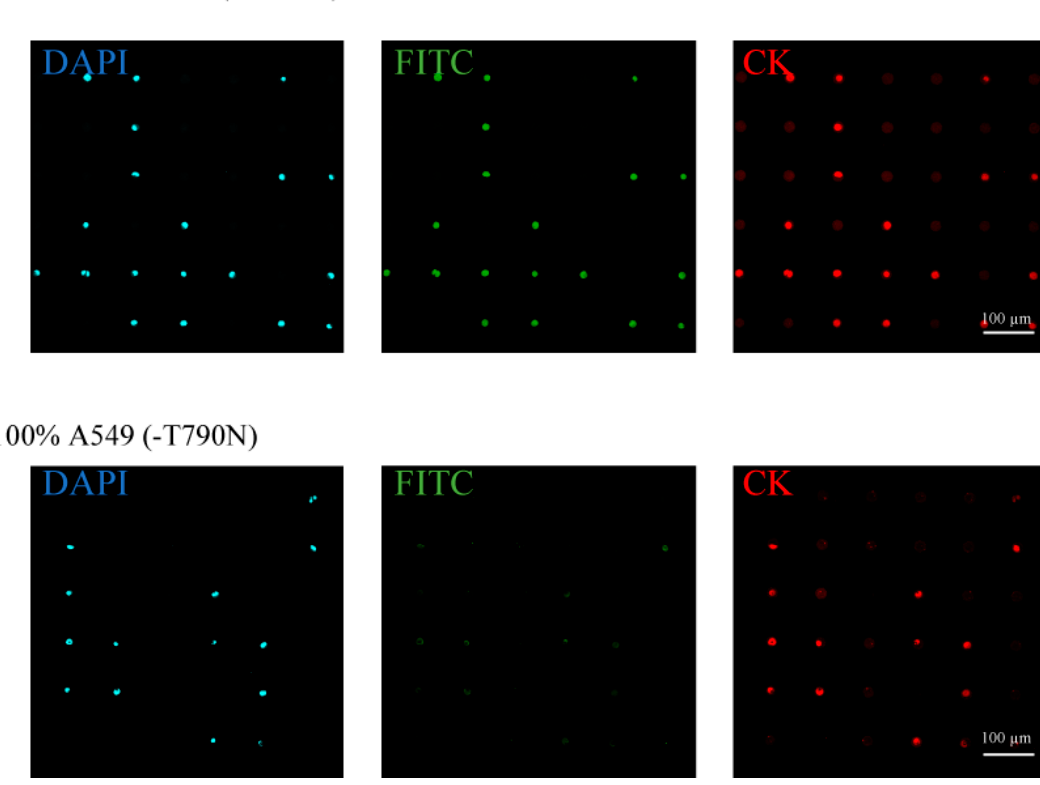
Figure 2. Separation and analysis of different lung cancer cell lines (NCI-H1975 and A549) on the single-cell microarray chip. The upper and lower figures show the representative fluorescent images of NCI-H1975 (T790M-mutated) and A549 (non-mutated) cells, respectively, stained by diluted 4,6-diamidino-2-phenylindole (DAPI; blue), fluorescein isothiocyanate (FITC)-conjugated peptide nucleic acid (PNA)-DNA probes (green), and phycoerythrin (PE)-labeled cytokeratin (CK) antibody (red).